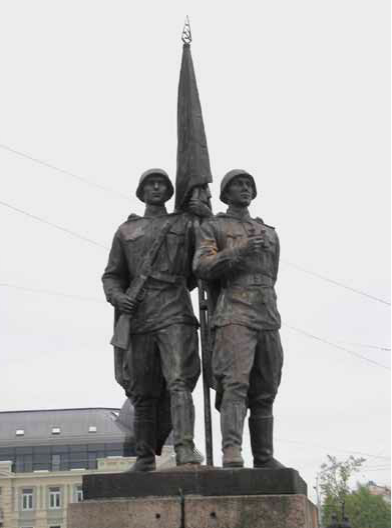
fig. 4. Victory obelisk in Minsk, Belarus. r. Čepaitienė photo fig. 5. Green Bridge sculptures in Vilnius,